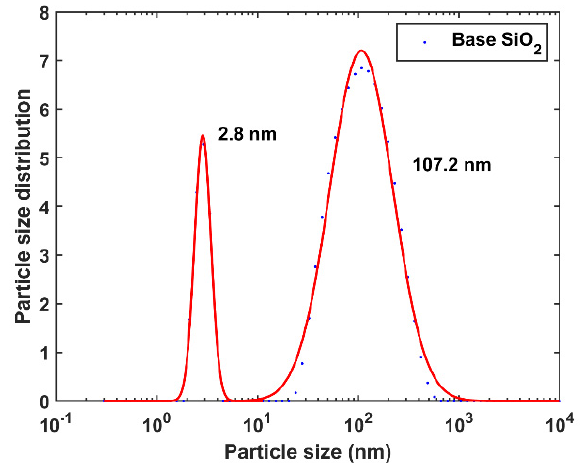
Figure 9. SiO 2 ASD test by DLS, with a Gaussian-type fitting mode (red solid line); peaks at 2.8 and 107.2 nm for the bimodal ASD curve.